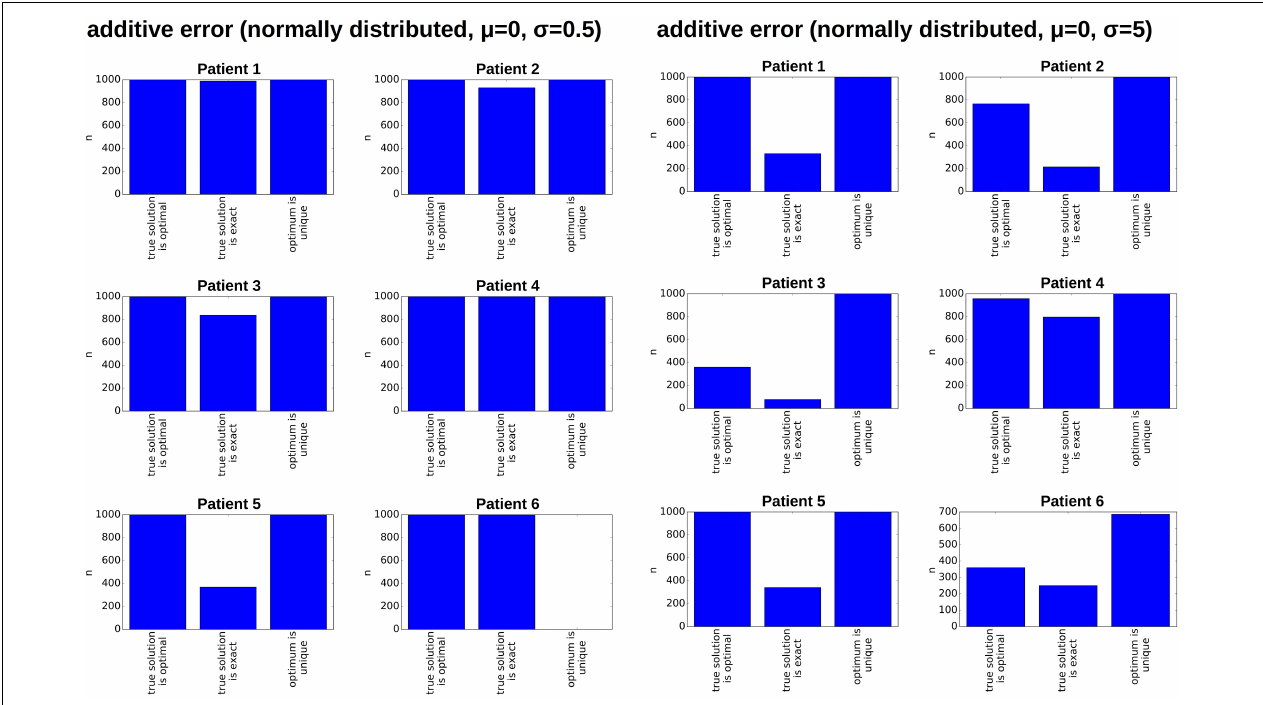
FIGURE 6 | Impact of measurement errors on the reconstructed hierarchies. For each patient, we generate 1,000 randomly perturbed pairs of diagnosis and relapse samples. The additive random perturbations were drawn from a normal distribution with mean zero and standard deviation 0.5% (left) or 5% (right), respectively. Perturbations leading to a VAF of less than zero or more than 100% were excluded. For each of the perturbed diagnosis/relapse pairs, we reconstructed all compatible clonal hierarchies. The figure indicates for how many of the 1,000 perturbed samples the true hierarchy optimally fits the perturbed data (compared to all other existing hierarchies), whether the true hierarchy can exactly reproduce the perturbed data and whether the optimal configuration is